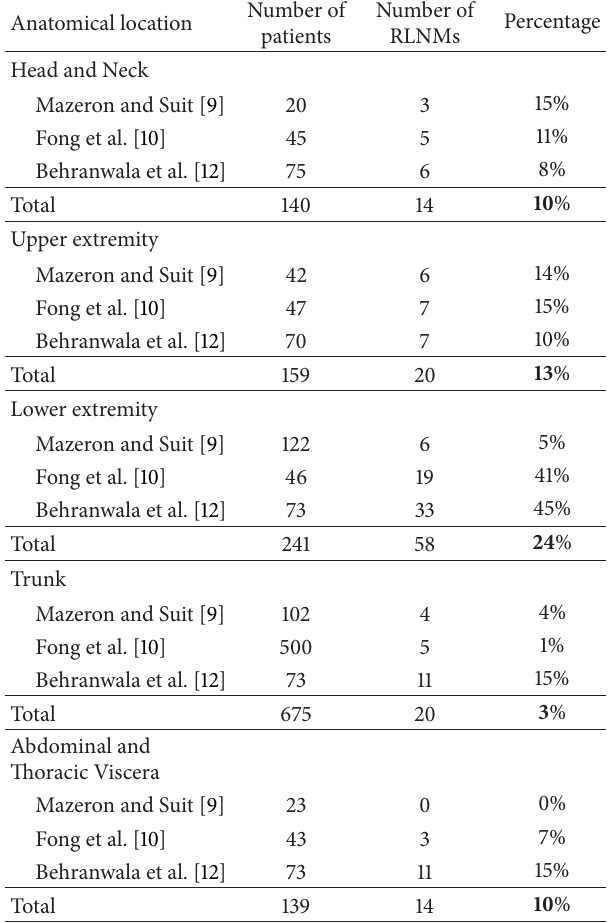
Table 2: Three studies on the number of patients with a STS who developed RLNM in various anatomical